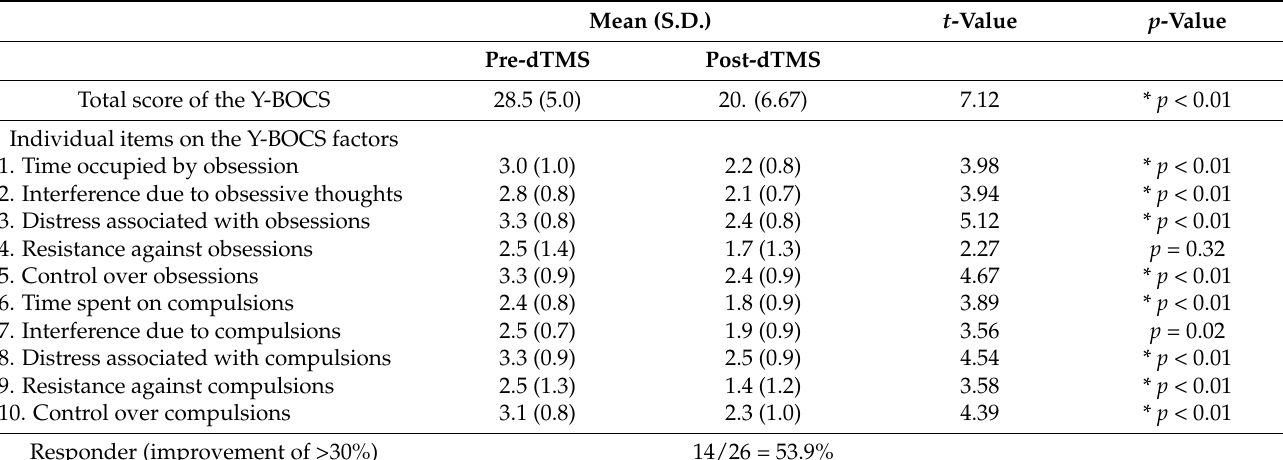
Table 3. Changes in individual items of the Y-BOCS following dTMS treatment combined with individualized exposure